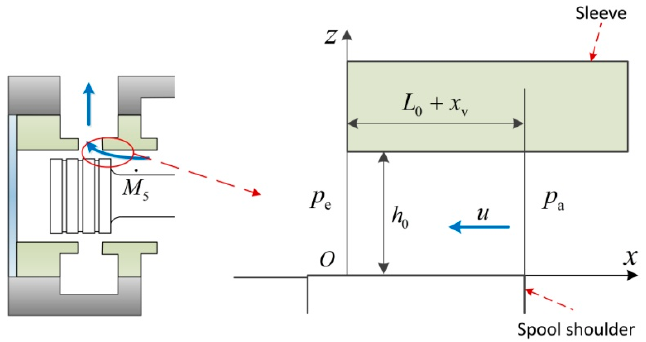
Figure 8. Schematic diagram of the clearance flow.